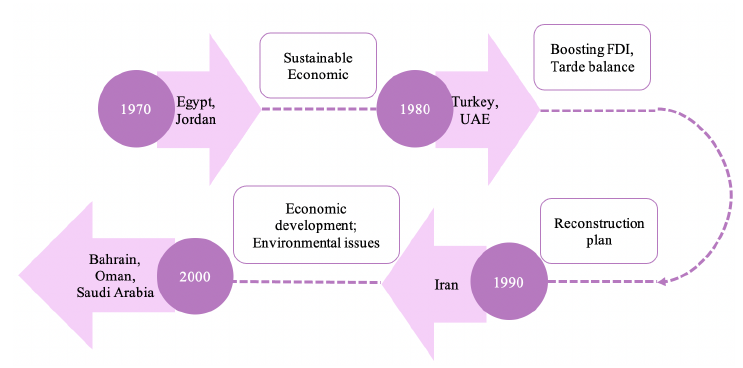
Figure 4. “The history of establishment of industrial park” on time line graph.